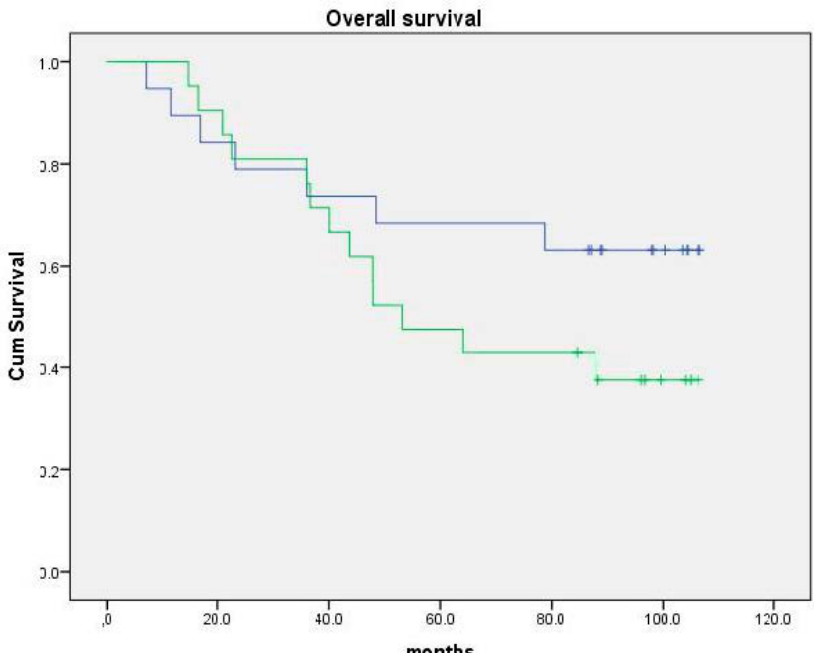
Figure 1. Follow-up of overall survival (OS) of patients included in the clinical study: Andosan TM as adjuvant treatment in MM patients receiving autologous stem cell transplantation (ASCT) [56]. Upper curve: Andosan TM group ( n = 19). Median OS = 79.0 months (95% CI 61.5–96.5 months). Lower curve: Placebo group ( n = 21). Median OS = 65.8 months (95% CI 50.5–80.9 months) Median observation time 67.7 months. p = 0.16. Previously unpublished result.